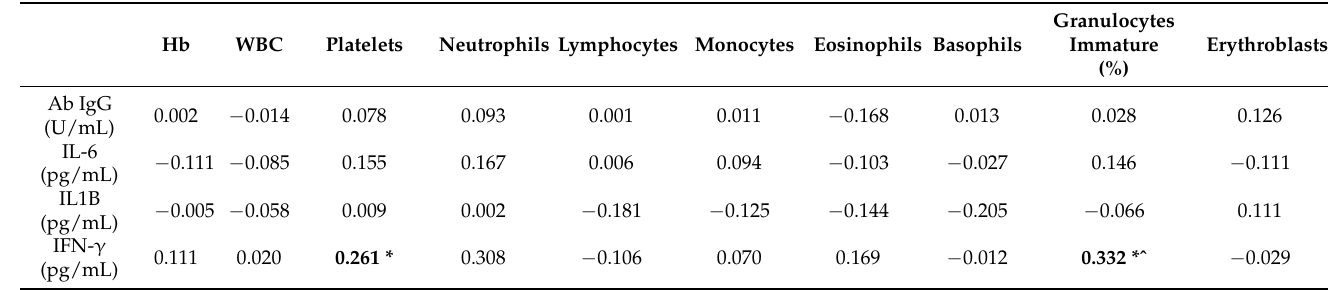
Table 7. Correlations between cytokines concentrations and umbilical cord blood cells count. Pear- son’s coefficient. Pearson’s significant correlation coefficients have been highlighted.